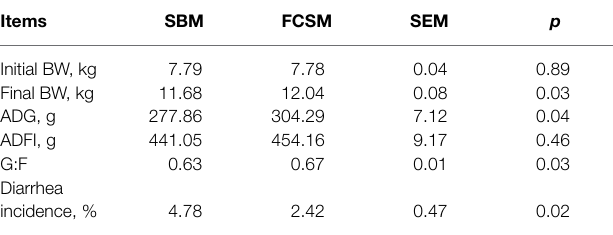
TABLE 4 | Effects of two protein source on apparent total tract digestibility and ileal digestibility of nutrients of weaned piglets